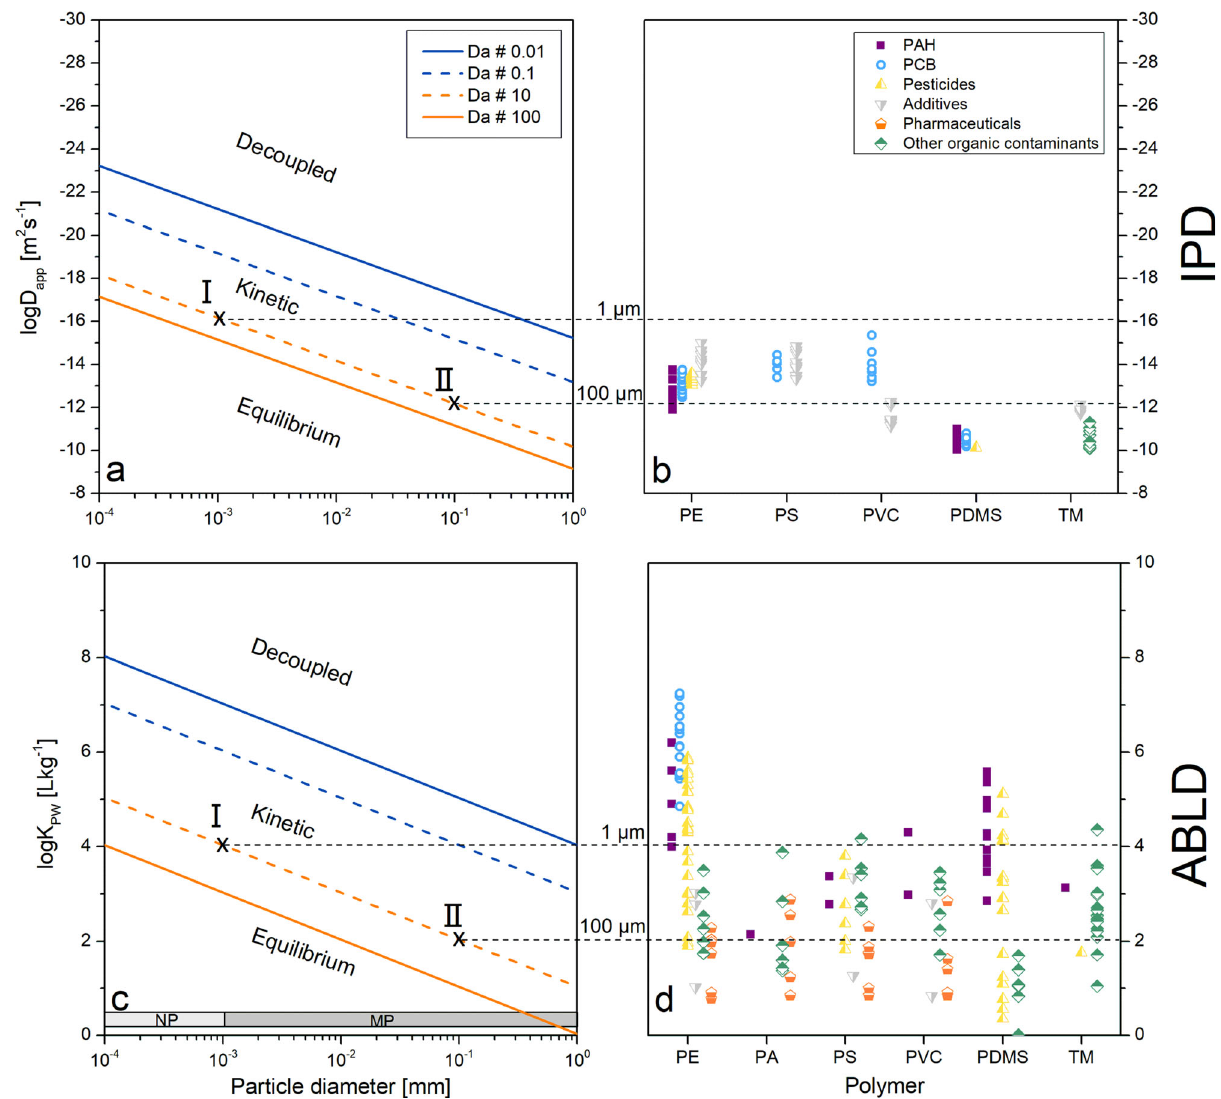
Fig. 3 Identi fi cation of MNP-facilitated transport of contaminants in farmland soils for a travel time of 1 m h − 1 using Damköhler numbers. Lines of equal Damköhler numbers indicate equilibrium conditions (>10 − 100) and decoupled transport (<0.1 − 0.01) depending on the particle size ( x -axis) and a the logD app for IPD or (c) log K PW for ABLD ( y -axis). b Log D app 30,39,71 – 77 and (d) log K PW 30,37 – 40,55,59,78 – 82 for contaminant groups and polymers reported in the literature: polyaromatic hydrocarbons (PAH) ( ), pesticides ( ), polychlorinated biphenyls (PCB) ( ), additives ( ▽ ), pharmaceuticals ( ) and other organic contaminants ( ) in polymers such as polyethylene (PE), polyamide (PA), polystyrene (PS), polyvinyl chloride (PVC), polydimethylsiloxane (PDMS) and tire materials